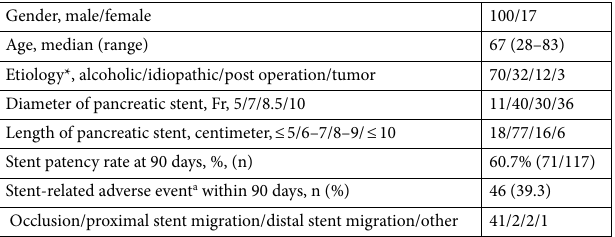
Table 1. Patients’ characteristics and clinical outcomes (n = 117). Fr , French. *Etiology of chronic pancreatitis. a Nine cases (7.7%) had an adverse event within 7 days, and 22 (18.8%) within 30 days.